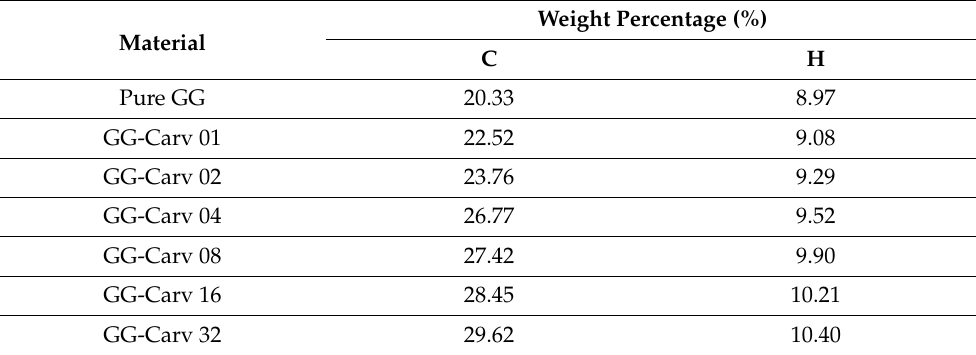
Table 1. Elemental analysis of weight percentage of carbon, C and hydrogen, H for pure GG and encapsulated GG-Carv with various concentrations of Carv.